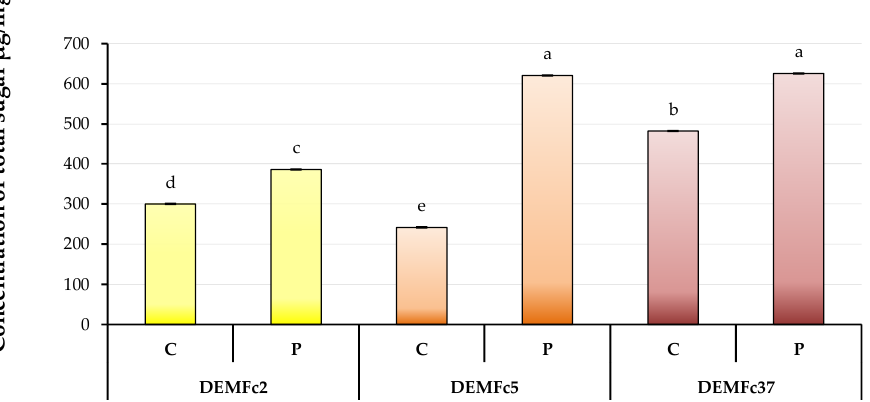
Figure 8. Total sugar in crude ( C ) and proteolysed ( P ) EPS obtained from cultures of three F. culmorum strains: DEMFc2, DEMFc5, and DEMFc37. ANOVA with post hoc Tukey’s HSD test, p < 0.05. Mean values labeled with the same letter are not significantly different ( p > 0.05). Standard deviations are shown as deviation bars ( n = 9).